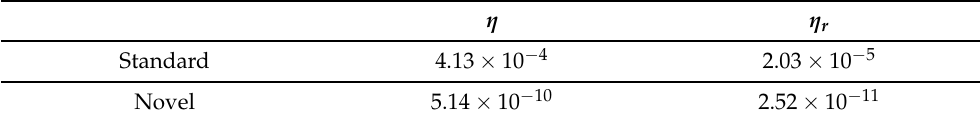
Table 2. [ E sct ] error.